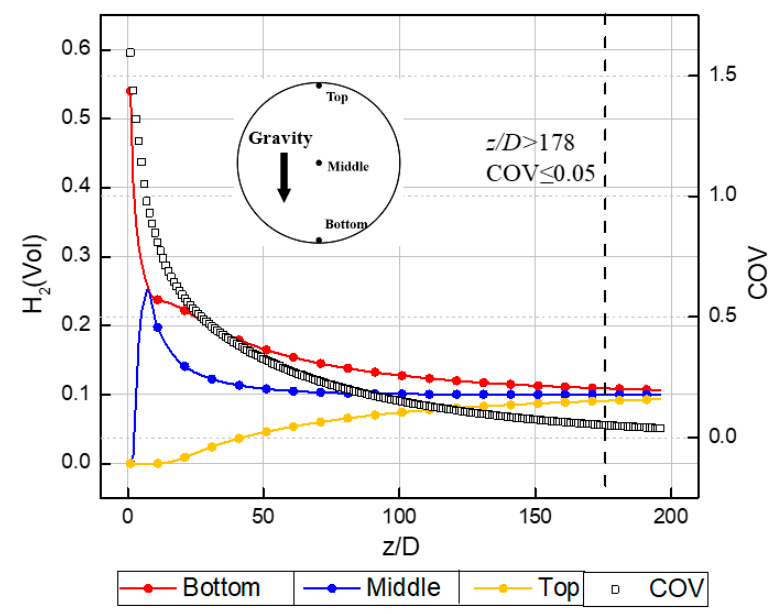
Figure 7. Variation of hydrogen concentration and COV on different pipeline cross sections ( = 10 m/s, v = 2.78 m/s, HBR = 10%, p = 0.3 MPa, T = 300 K, and d / D = 0.2).